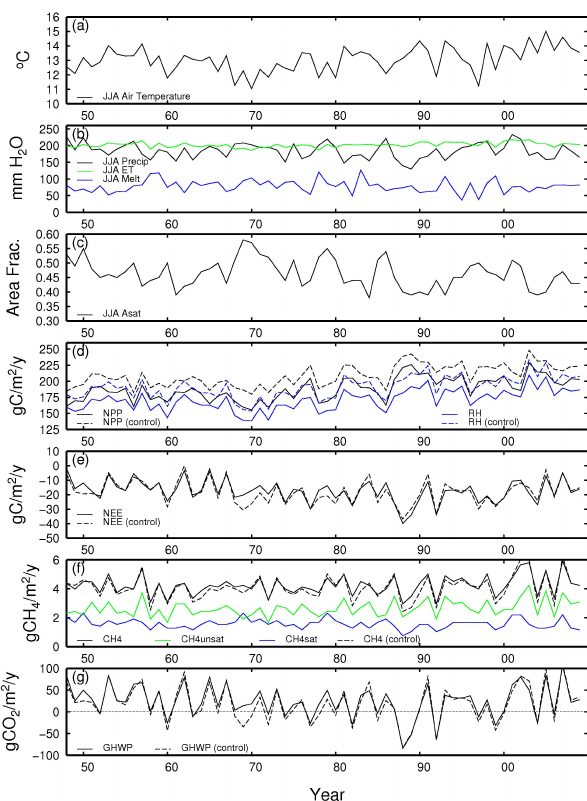
Fig. 9. 1948–2010 annual meteorological forcings and simulated states and